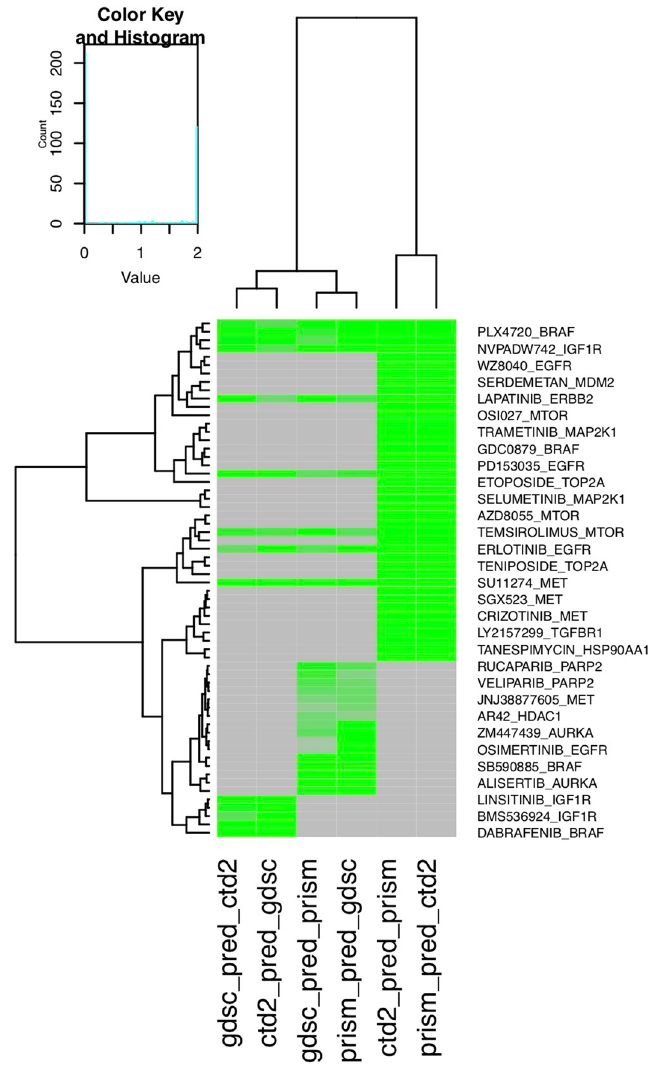
predictions versus the ground truth data. Gray indicates that the model is not available; i.e., the drug does not exist in either data set. Models with a more intense green colors have better